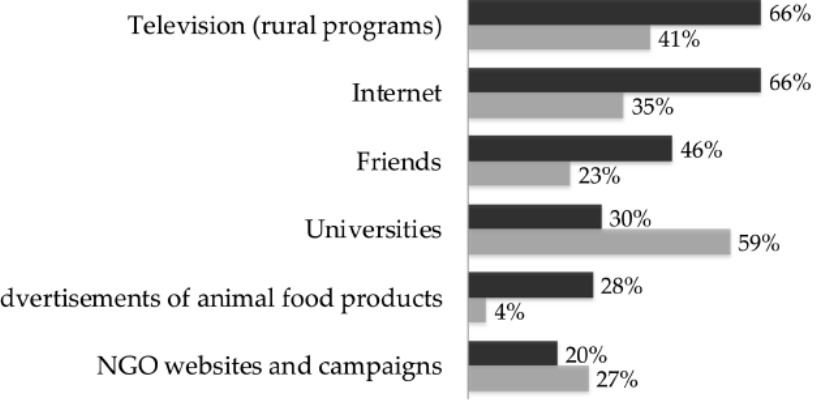
Table 1. Descriptive data on acceptability (%) of the di ff erent methods to deal with boar taint in pig